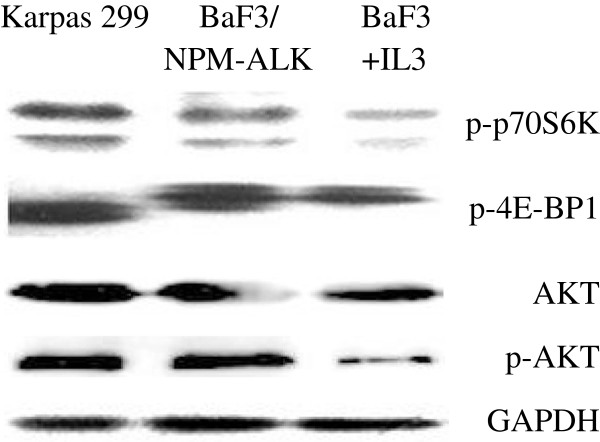
Overexpression of NPM-ALK activated the AKT/mTOR pathway. Overexpression of NPM-ALK in BaF3 cells induced hyper-activation of the AKT/mTOR pathway, as demonstrated by hyperphosphorylation of AKT and downstream molecules of mTOR: 4E-BP1 and p70SK6.